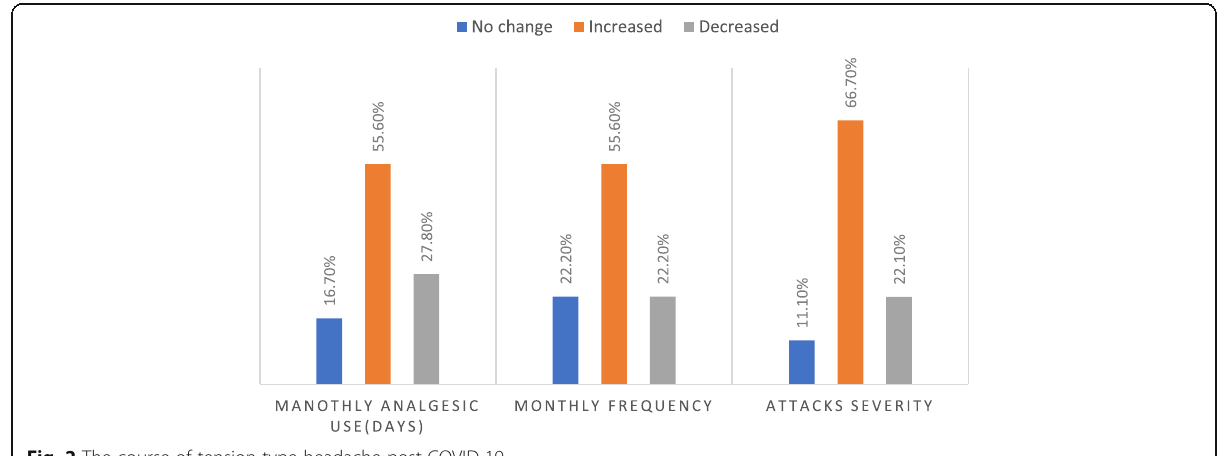
Fig. 2 The course of tension type headache